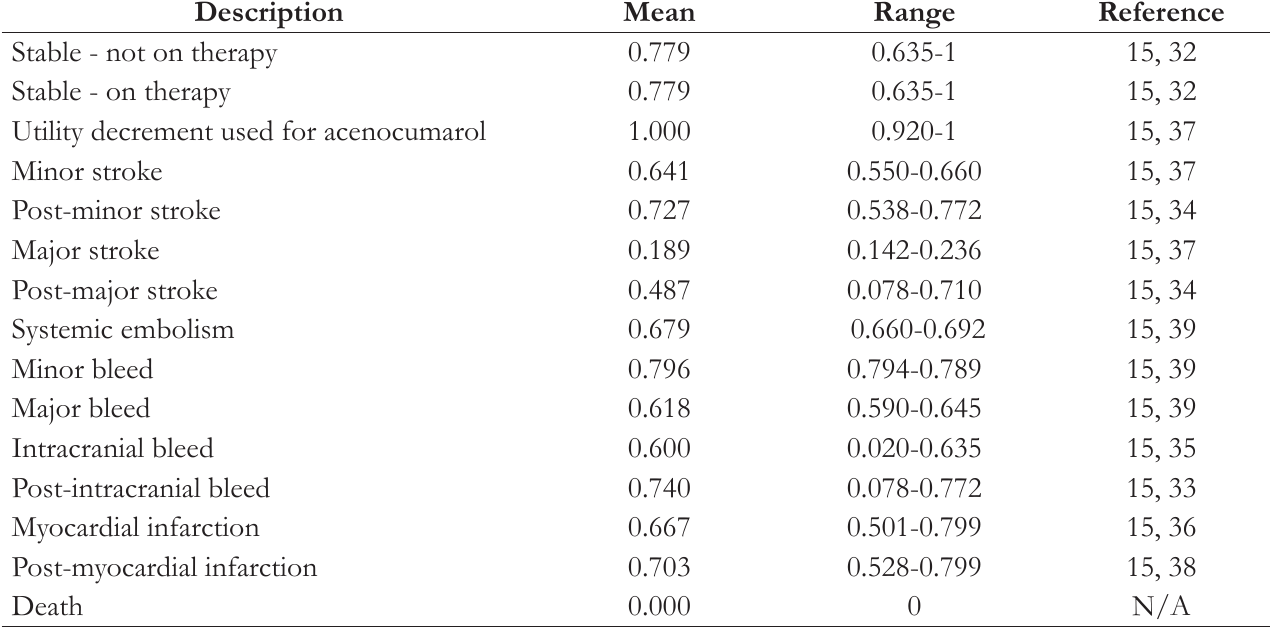
Table 4. Utility